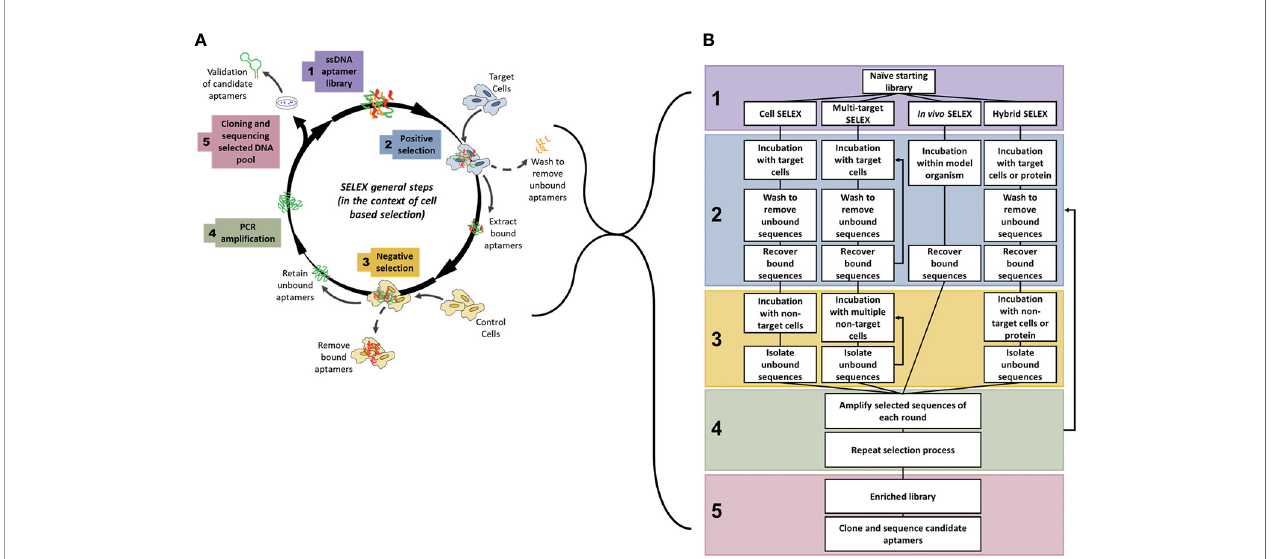
FIGURE 1 | General steps of aptamer selection. (A) SELEX follows 5 main steps to generate a highly speci fi c targeting aptamer. Step 1 involves the synthesis of a naïve library, with on average 10 18 random aptamer sequences per library. The 2 nd step is where selection begins, often with a positive round where the naïve library is targeted to cells or proteins of interest, after an incubation period with the target the bound aptamer sequences are recovered from the target cells. The 3 rd main step of SELEX is the negative selection step where the positively selected pool of sequences is incubated with non-target cells or proteins to separate out off-target aptamer sequences. Only unbound aptamers are kept from this step. The 4 th step is to amplify the selected pool and repeat the cycle of positive and negative selection rounds until the aptamer pool is suf fi ciently enriched to only contain sequences that bind speci fi cally to the target. In the 5 th and fi nal step of SELEX the enriched pool is cloned and sequenced to identify candidate aptamers (Ellington and Szostak, 1990; Tuerk and Gold, 1990; Shangguan et al., 2006). (B) Comparison of various types of SELEX, grouped by main steps of generation. Note: In multi-target SELEX either or both of the selection steps may be repeated through multiple targets, either sequentially or as a combined